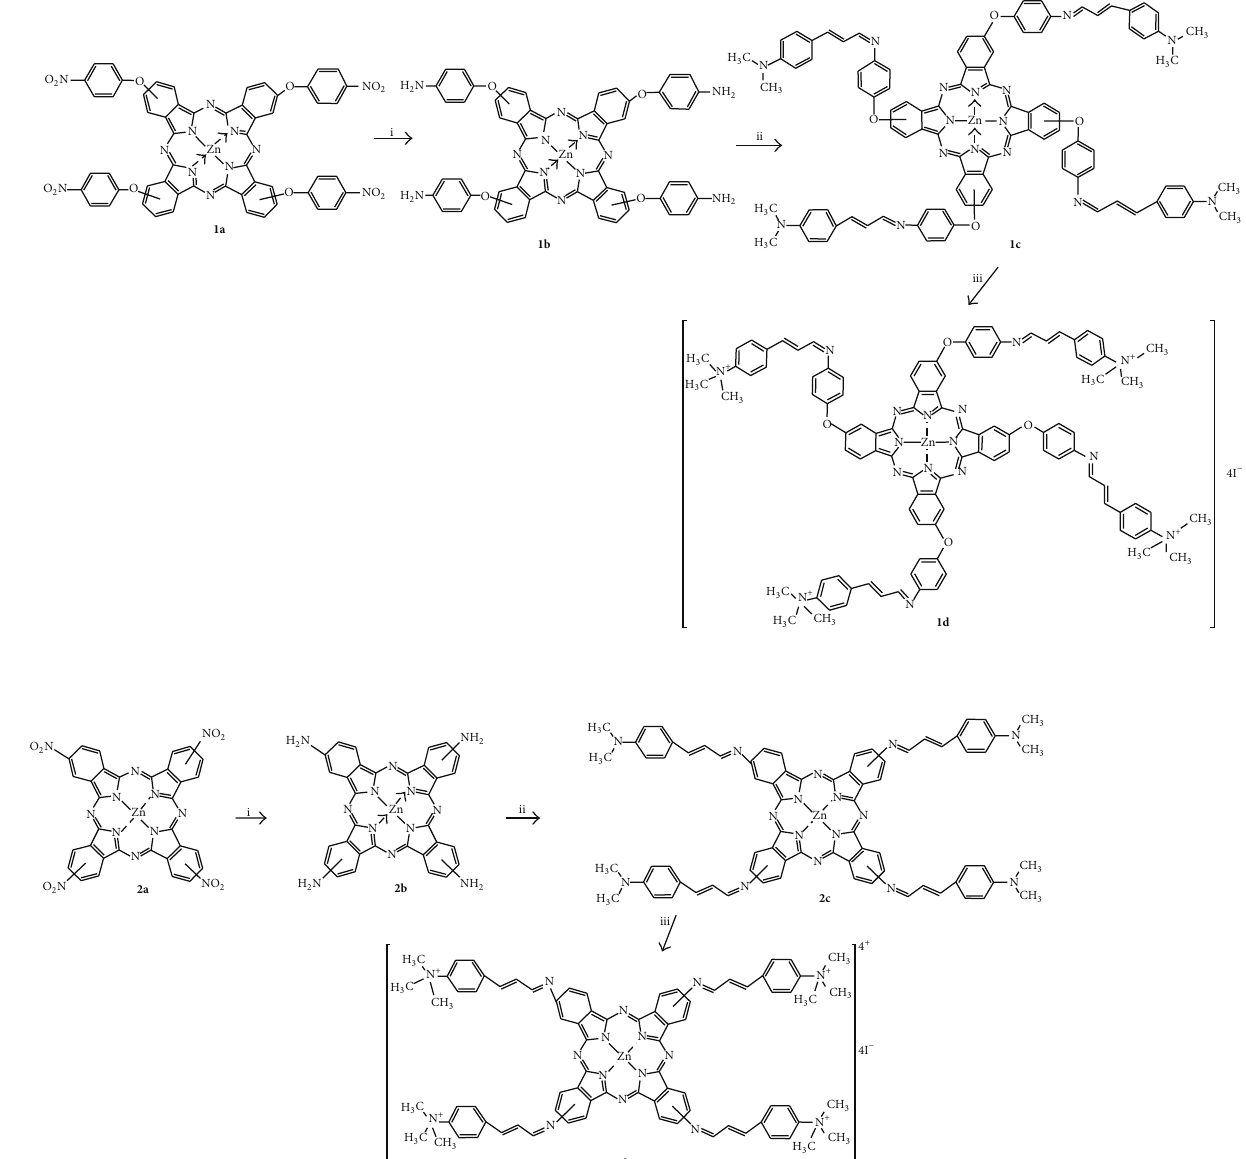
Scheme 1: Synthesis of zinc complexes. 1a–1d and 2a–2d ((i) Pd/C, hydrazine hydrate, dioxane, and reflux; (ii) 4-(dimethylamino) cinnamaldehyde, THF, and reflux; (iii) CH 3 I, CHCl 3 , and reflux) [22, 23].